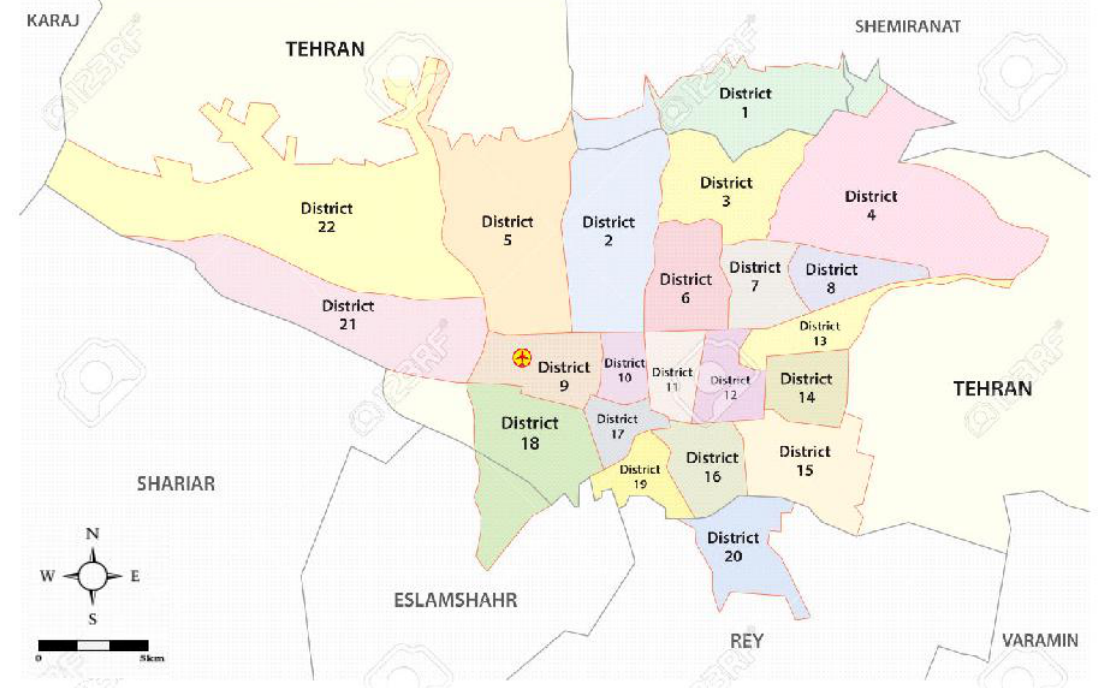
Fig. 1: Map showing study area within Tehran metropolitan